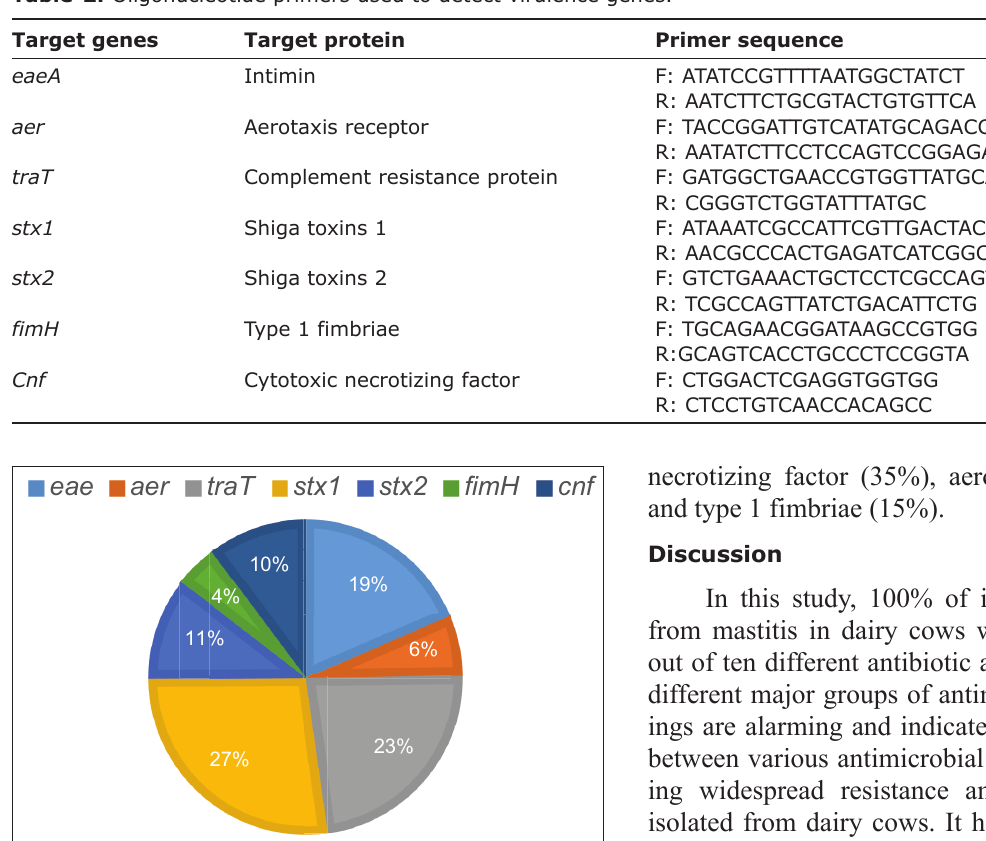
Figure-2: Frequency (%) of E. coli isolates from bovine mastitis carrying different virulence genes.